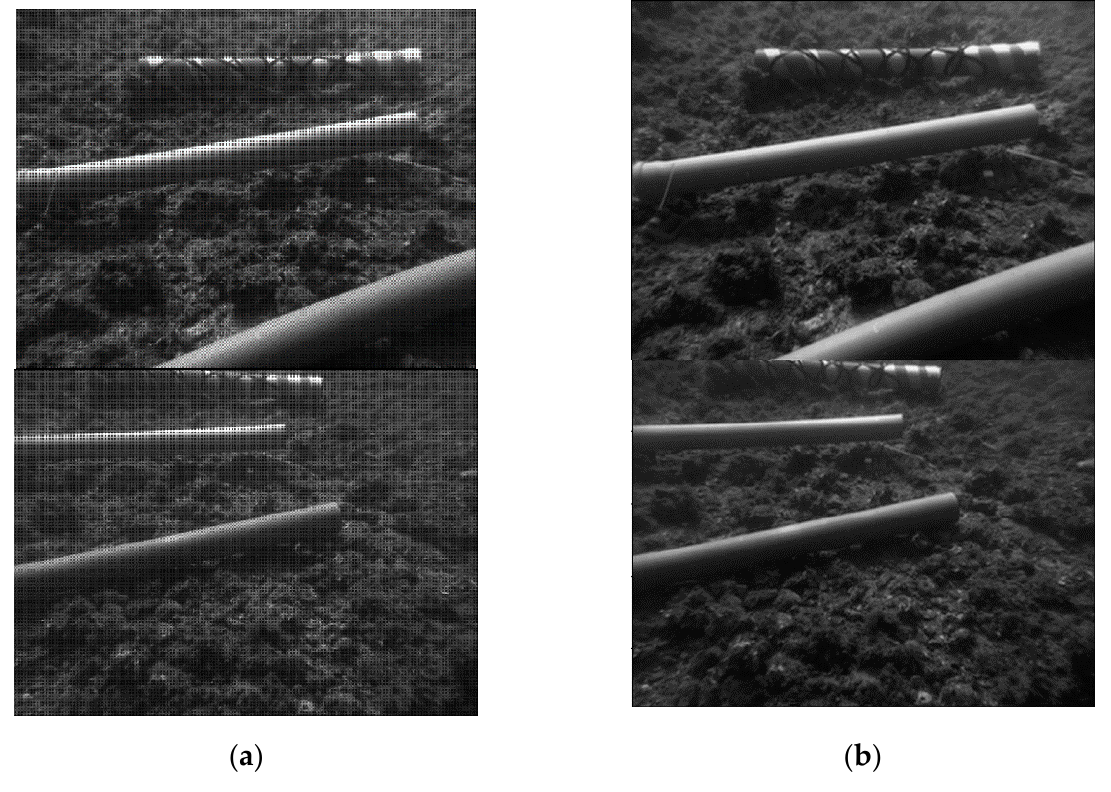
Figure 2. Underwater pipe image noise removal ( a ) Original image and ( b ) Output image.